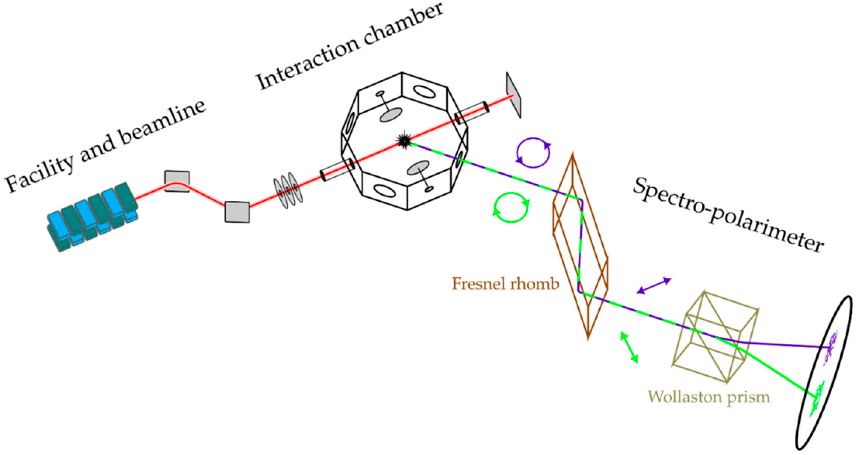
Figure 2. An overview of the experimental set-up illustrating the experimental geometry, design of the interaction chamber and spectro-polarimeter with details of the polarization analysis (see text).